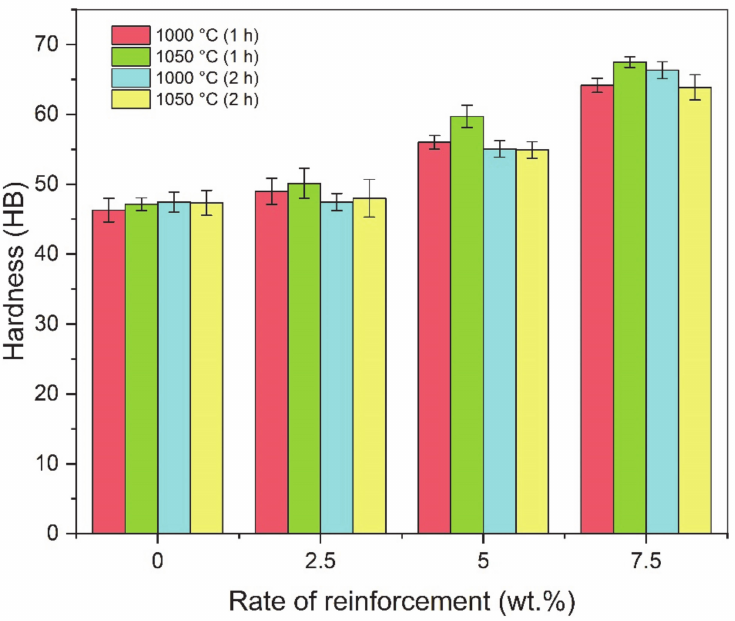
Figure 7. Hardness graph of composites sintered at different times and